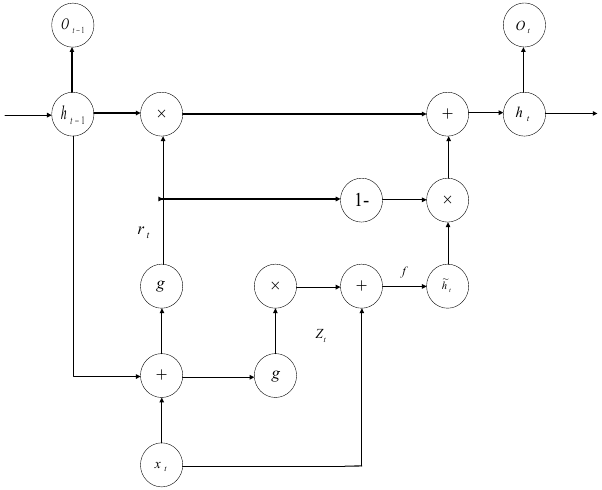
Figure 8. Structure diagram of hidden layer of GRU neural network.